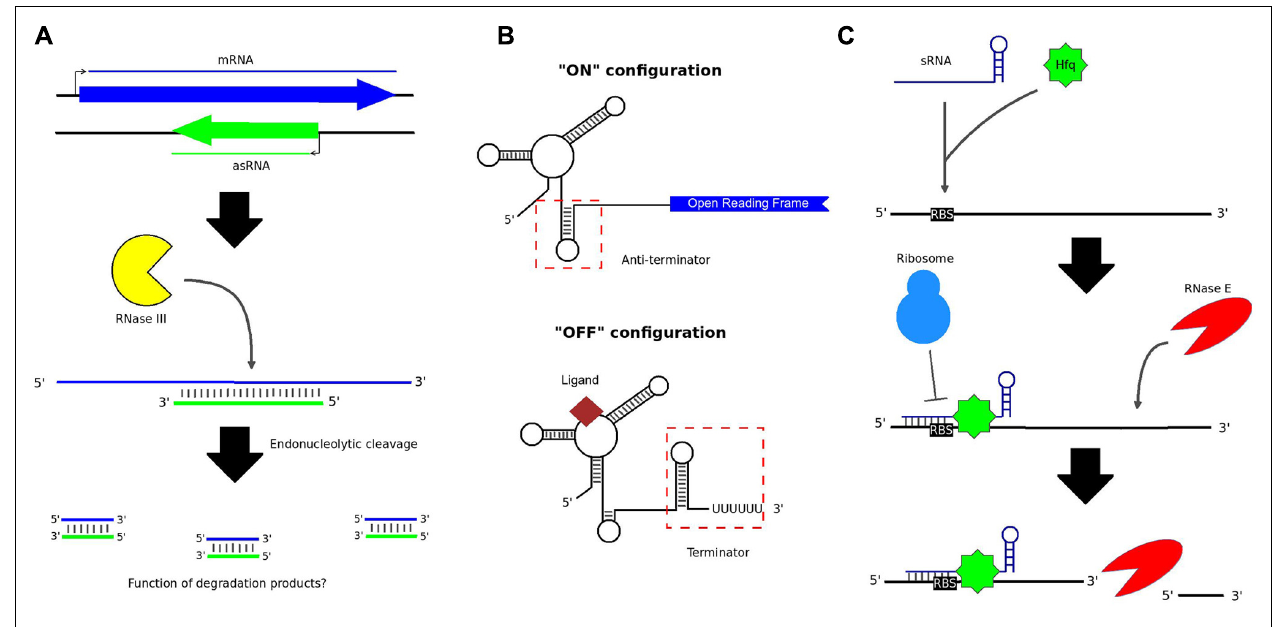
folding to form either terminator or anti-terminator hairpin loops, depending on the presence or absence of an appropriate signal ligand. (C) Intergenic sRNAs typically work in combination with the Hfq chaperone protein, binding the RBS of target mRNA transcripts and preventing translation of the mRNA. RNase E cleavage of the mRNA may subsequently